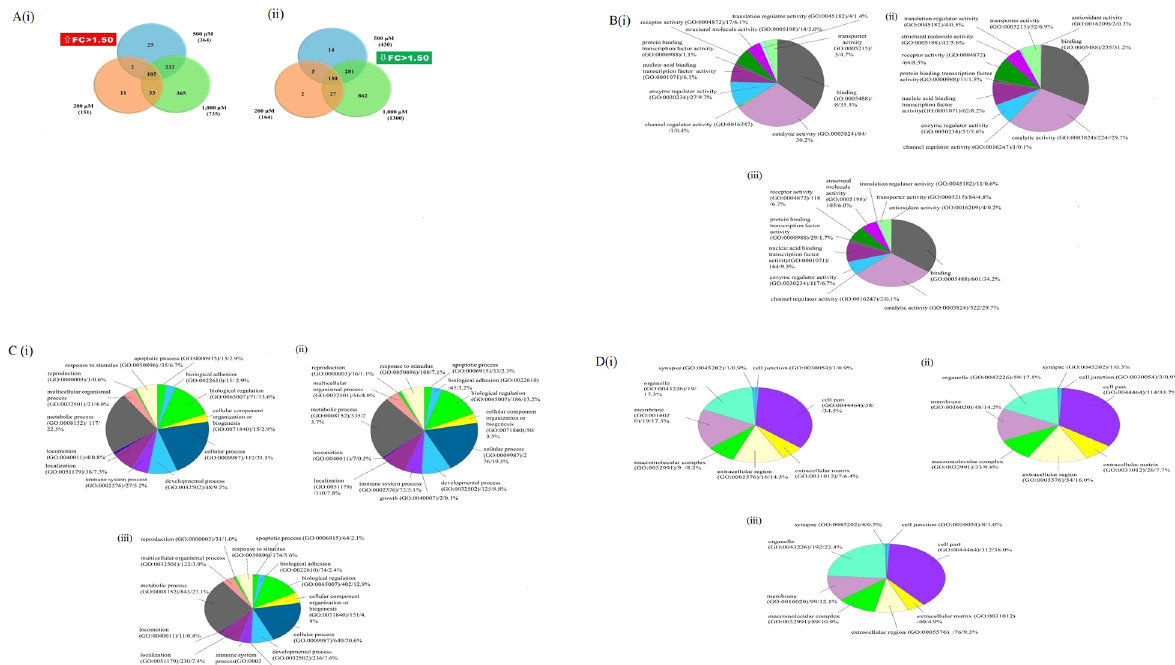
Fig. 1 Venn diagram and Functional analyses of differentially expressed genes of ASA treatments. A Venn diagram representing the number of DEGs that are shared among the 200, 500, and 1000 μ M ASA-treated samples. (FC 1.5: Fold Change Upregulated); B(ii)FC 1.5: Fold Change Downregulated; B Functional analyses of differentially expressed genes by PANTHER. Representative GO terms of Biological Processes (BP) at B (i) 200 μ M, B (ii) 500 μ M and B (iii) 1000 μ M of ASA treatments. C; Functional analyses of differentially expressed genes by PANTHER. Representative GO terms of Molecular Functions (MFs) at C (i) 200 μ M, C (ii) 500 μ M and C (iii) 1000 μ M of ASA treatments. Functional analyses of differentially expressed genes by PANTHER. Representative GO terms of cellular components (CCs) at D (i) 200 μ M, D (ii) 500 μ M and D (iii) 1000 μ M of ASA